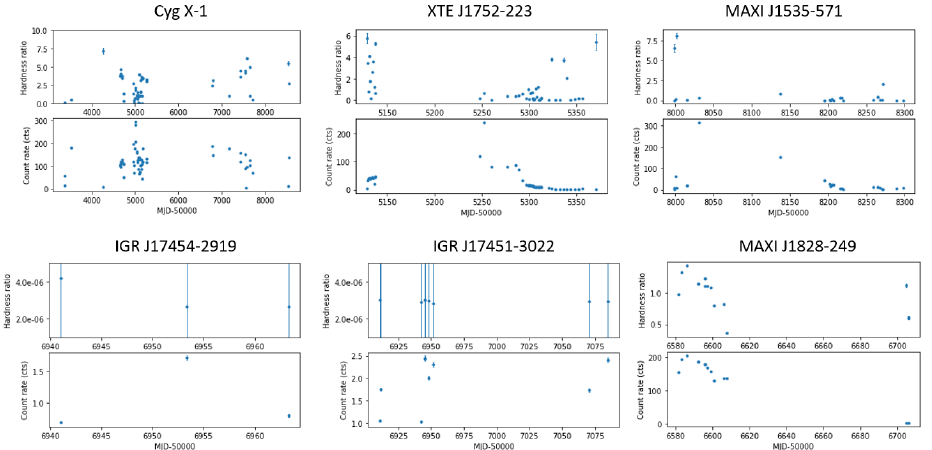
Fig. 6. The upper panel is the hardness ratio evolution and the lower panel is the light curve in terms of count rate.